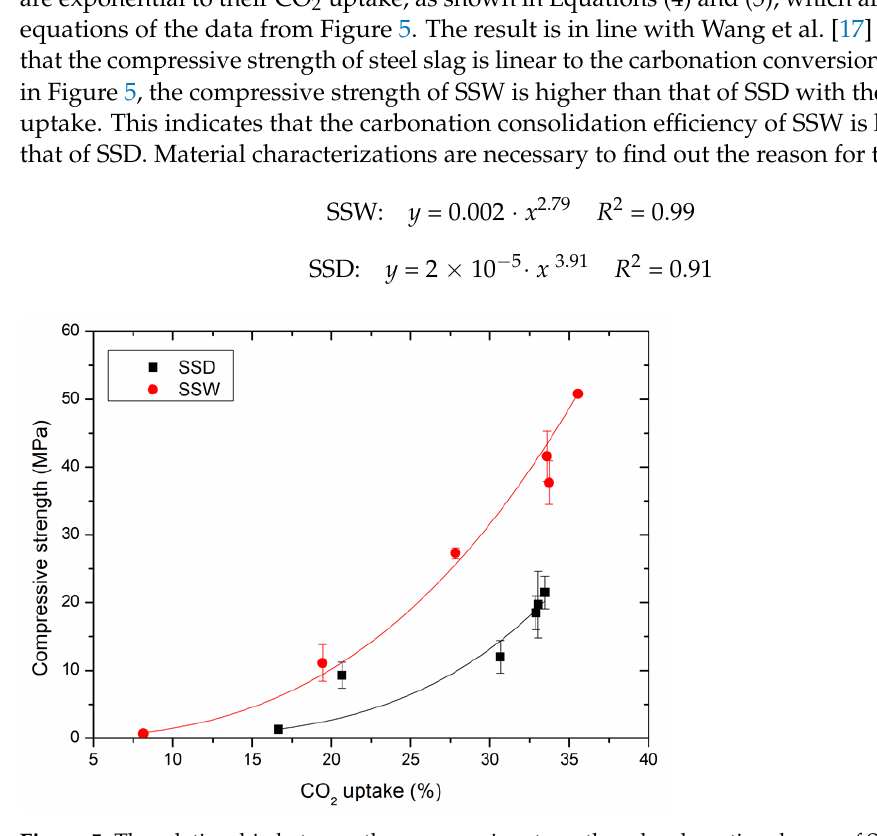
Figure 5. The relationship between the compressive strength and carbonation degree of SSD and